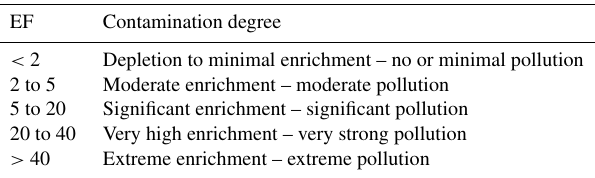
Table 5. The categories of pollution according to the enrichment